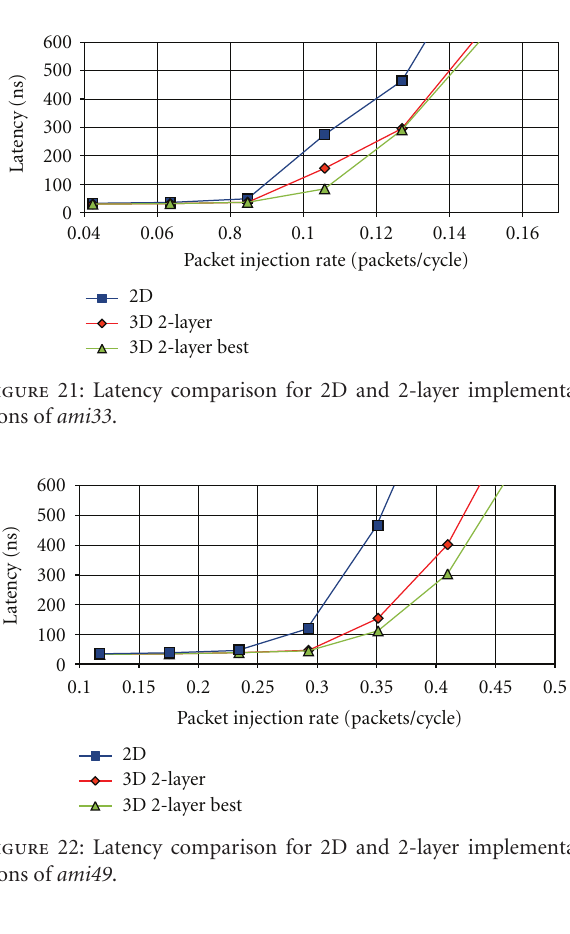
Figure 20: Latency comparison for 2D and 2-layer implementa- tions of ami25 .